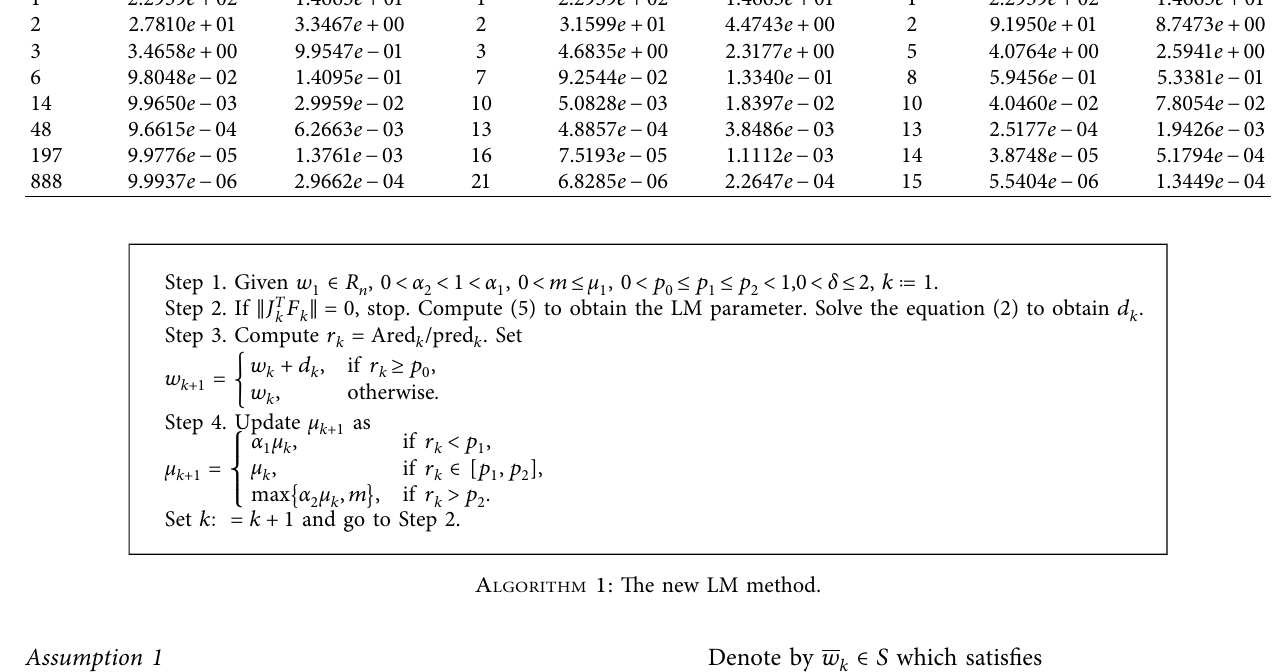
Table 1: Results for Powell singular function with initial point w δ � 10 − 4 (left), δ � 0 . 5 (middle), and δ � 1 (right). Iters ‖ J T k F k ‖ Function Iters ‖ J T k F k ‖ Function Iters ‖ J T k F k ‖ Function